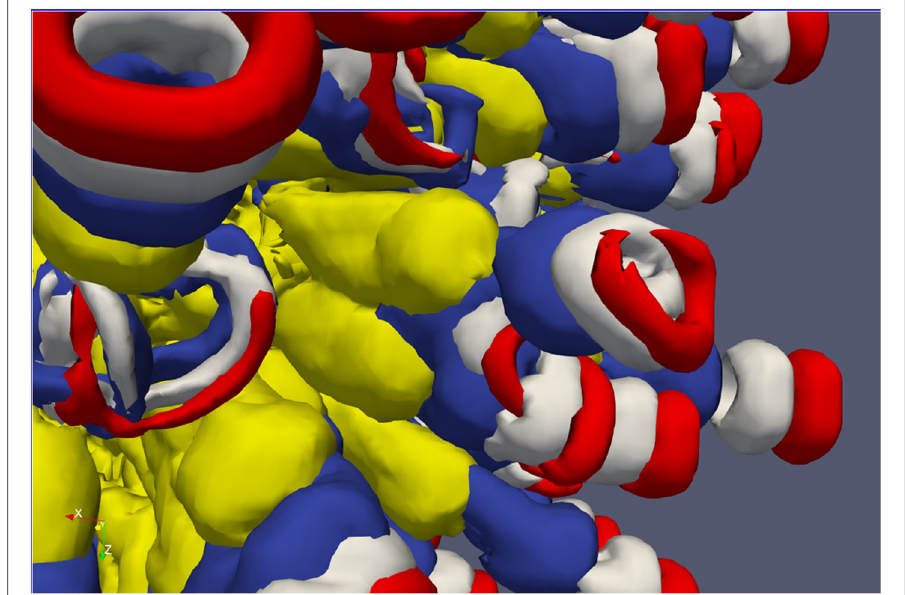
Fig. 4 Evolution of the high component of turbulence in 4 consecutive